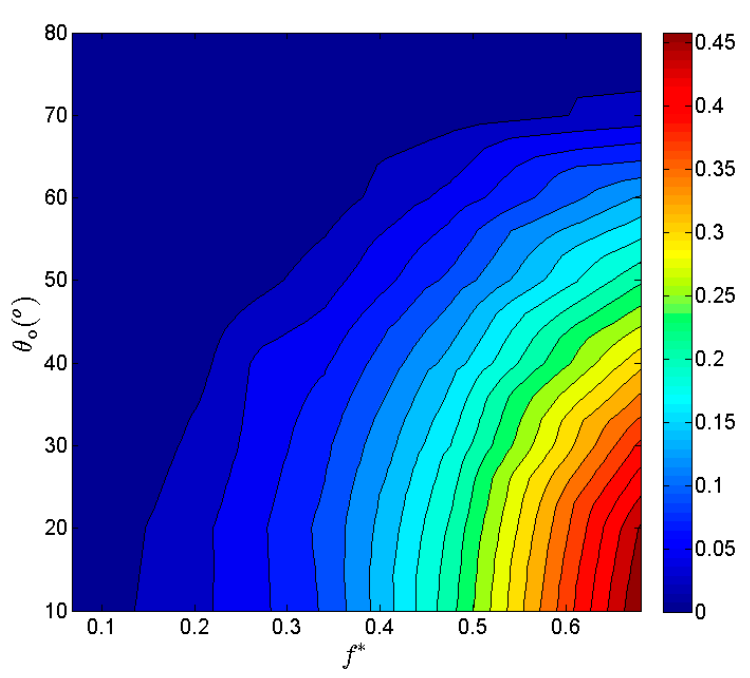
Figure 5. The propulsion efficiency contour on the parametric space of reduced frequency and pitching amplitude.